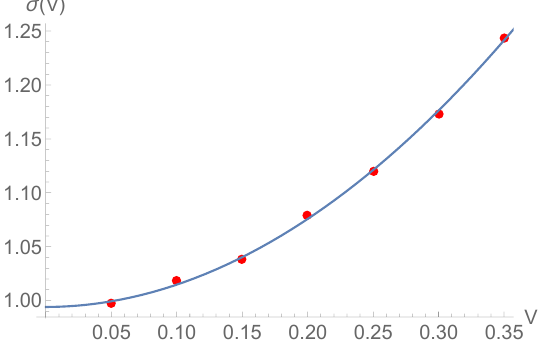
Figure 10 . Behavior of ~ (cid:27) de(cid:12)ned in eq. (4.9) as a function of (cid:22) V . The solid line corresponds to a (cid:12)t with a model of the form a + b (cid:22) V (cid:13) with a = 0 : 99, b = 1 : 98, (cid:13) = 1 : 98. We plot our results for this quantity with k = 5, N = 20, (cid:14) = 0 : 01 and varying (cid:22) V 0 in (cid:12)gure 10. Once again, we obtain a quadratic dependence of the suppression with the disorder